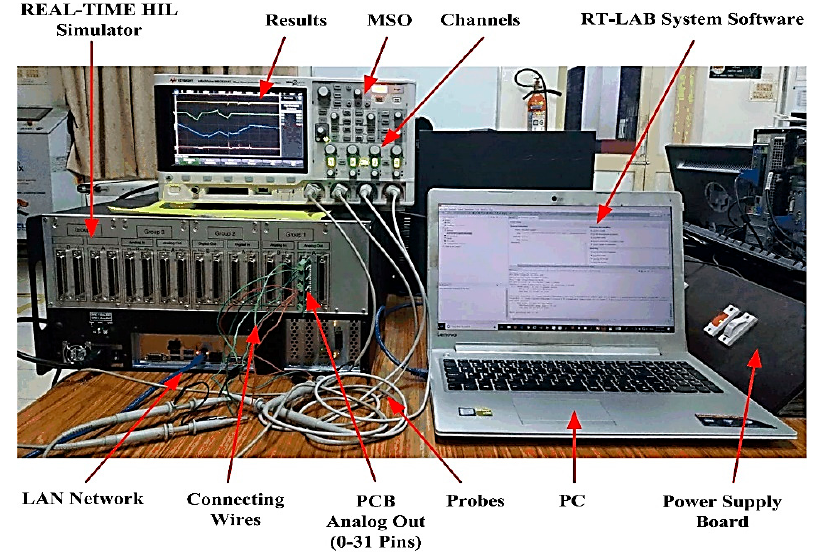
Figure 10. Real-Time (RT) results setup.